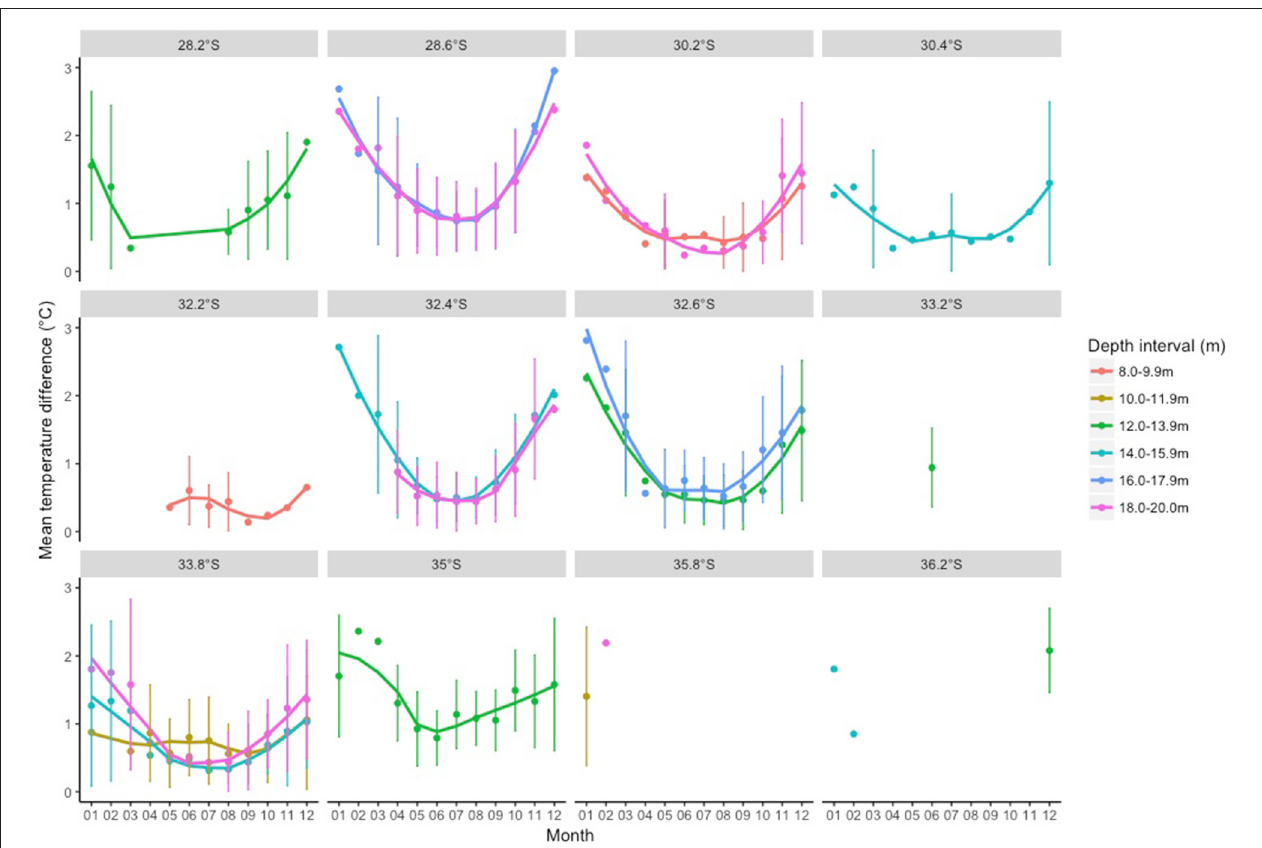
FIGURE 10 | Mean temperature differences between in situ and satellite that was processed at each logger location using an area average of 8km across shelf and 20km along shelf with a rolling mean based on the de-correlation time for the in situ location to fill in missing data (i.e. area- and time- averaged values).